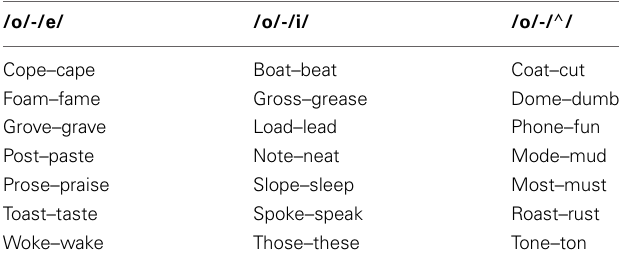
Table 1 | Stimulus word pairs used in